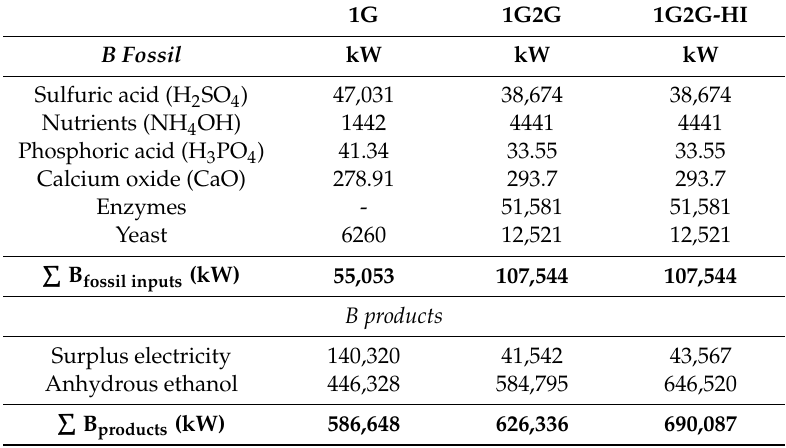
Table A14. Estimated exergy terms involved in renewability exergy